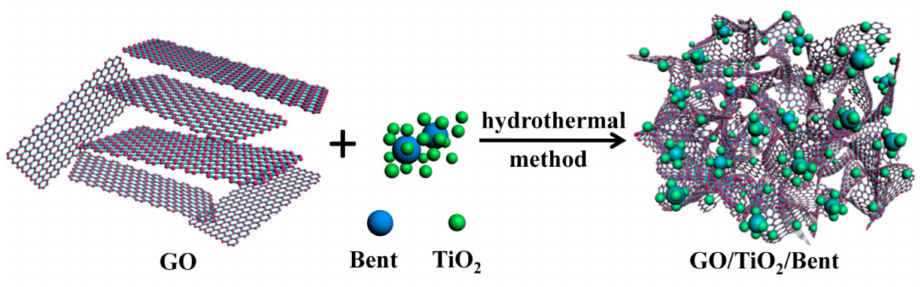
Figure 1. Scheme for the preparation of GO / TiO 2 / Bent